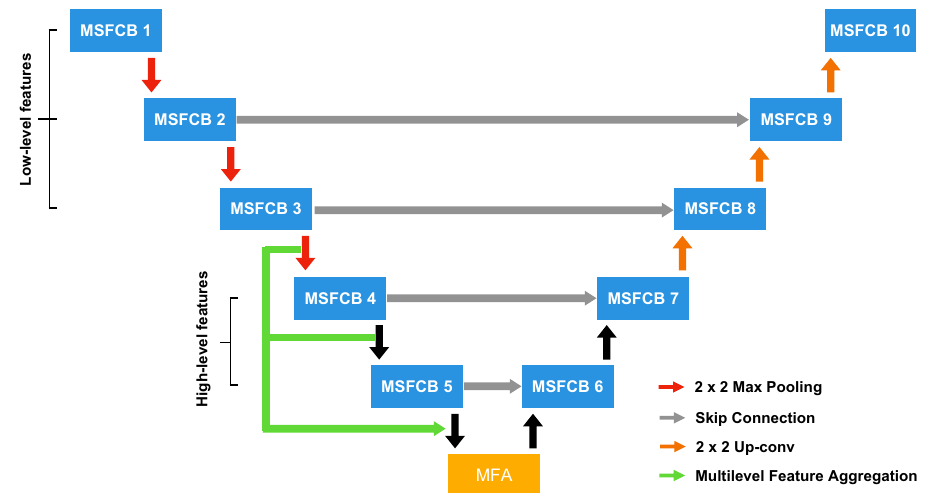
Figure 3. Proposed MSDC-Net architecture. The convolutional blocks are replaced by the proposed MSFCB. Moreover, an MLFA module is proposed to aggregate features of different levels in the downsampling process, instead of using only low-level features during upsampling.